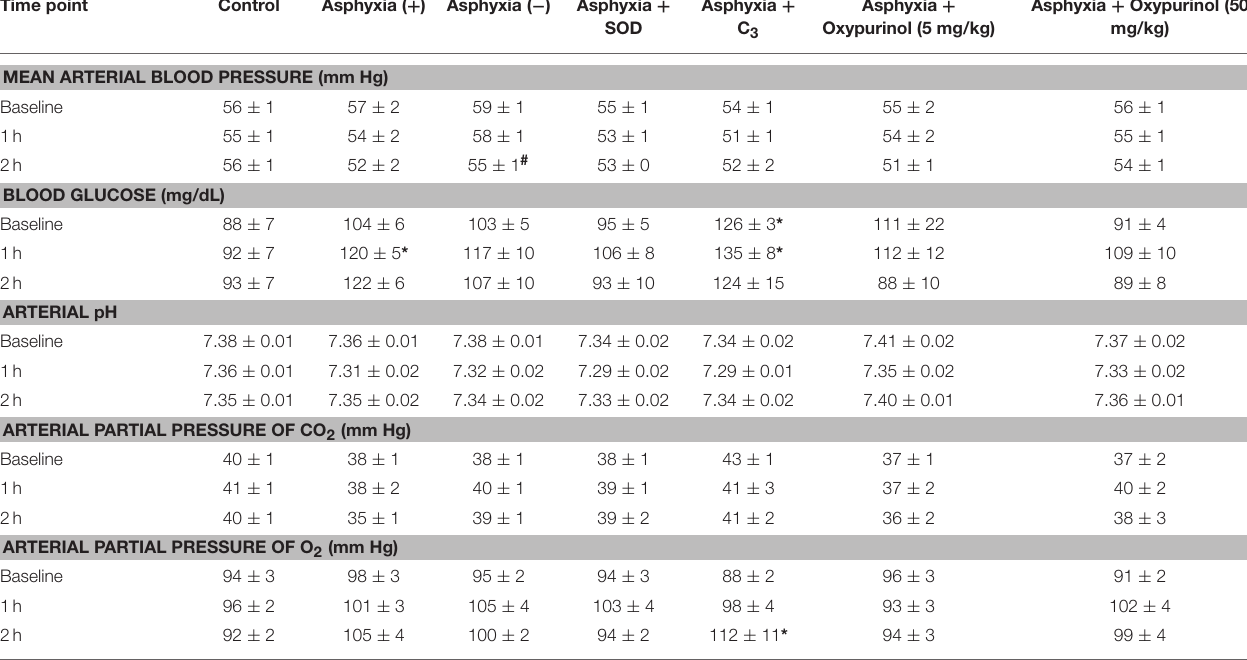
TABLE 1 | Values are means ± S.E.M. Baseline values reported are averaged from two measurements recorded 30min apart. Time